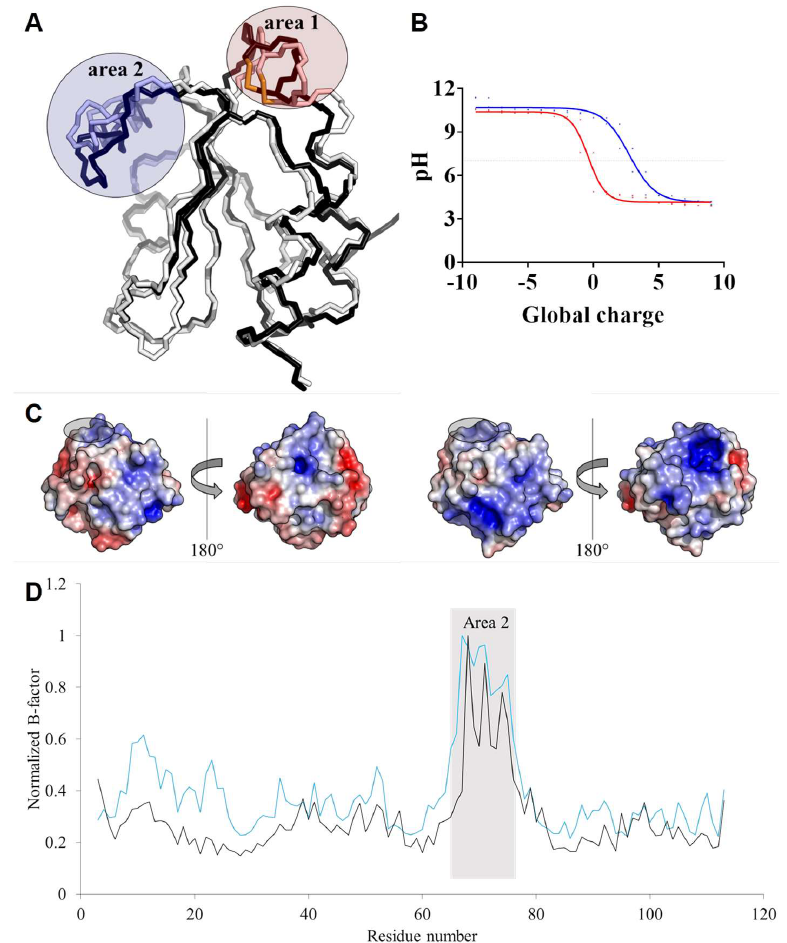
Figure 5. Structural features vs. charge and crystallographic B-factor distribution. ( A ) Structure superposition of the backbone trace of Arabidopsis TRXo isoforms. AtTRXo1 and AtTRXo2 are colored in white and black, respectively. The two divergent areas are circled in red and blue, respectively. ( B ) Global protein charge of AtTRXo1 (red) and AtTRXo2 (blue) as a function of pH as indicated by the PDB2PQR Server [54]. The dot line corresponds to pH 7.0. ( C ) Electrostatic potential mapped onto AtTRXo1 (left) and AtTRXo2 (right) structures at pH 8.1. The WCGPC signature residues are circled in black. ( D ) Flexibility of AtTRXo1 (black) and AtTRXo2 (blue) related to the crystallographic B-factor.